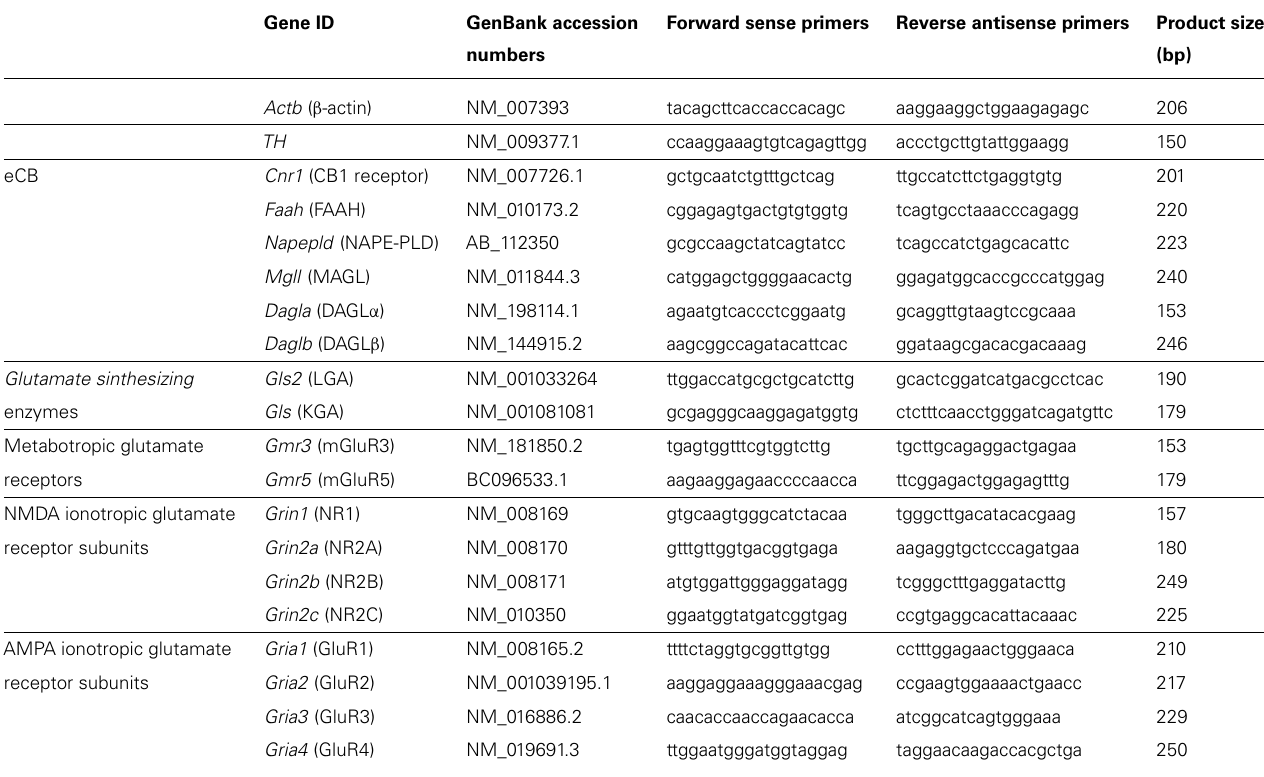
Table 1 | Primers sequences used for RT-PCR 1